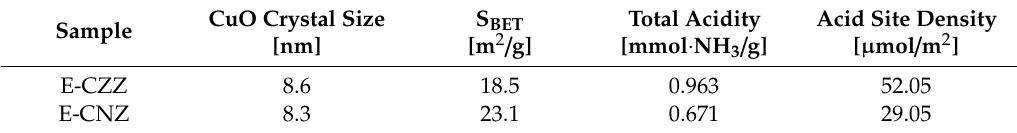
Table 1. Summary of the data obtained from XRD, N 2 -physisorption, and Temperature-Programmed Ammonia Desorption (TPAD).